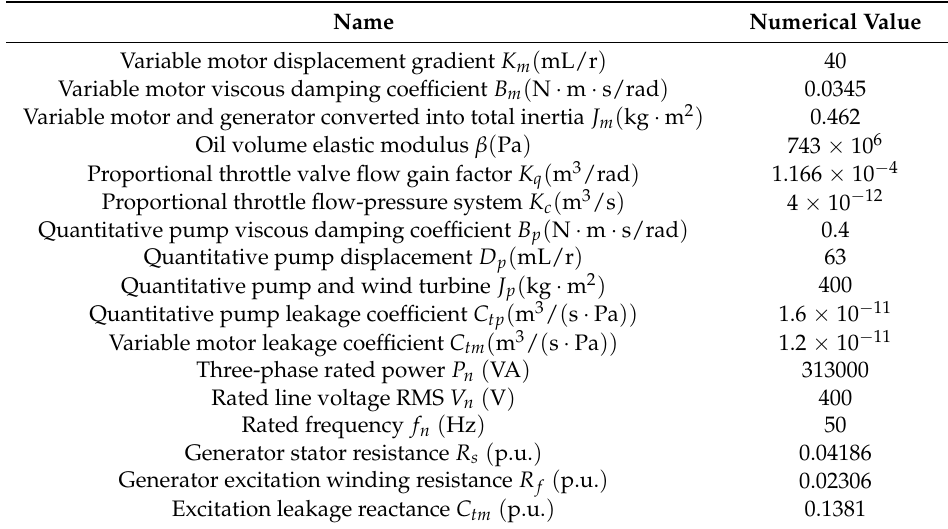
Figure 8. Main hydraulic drive system simulation model. Table 1. Simulation platform hydraulic system parameter values.